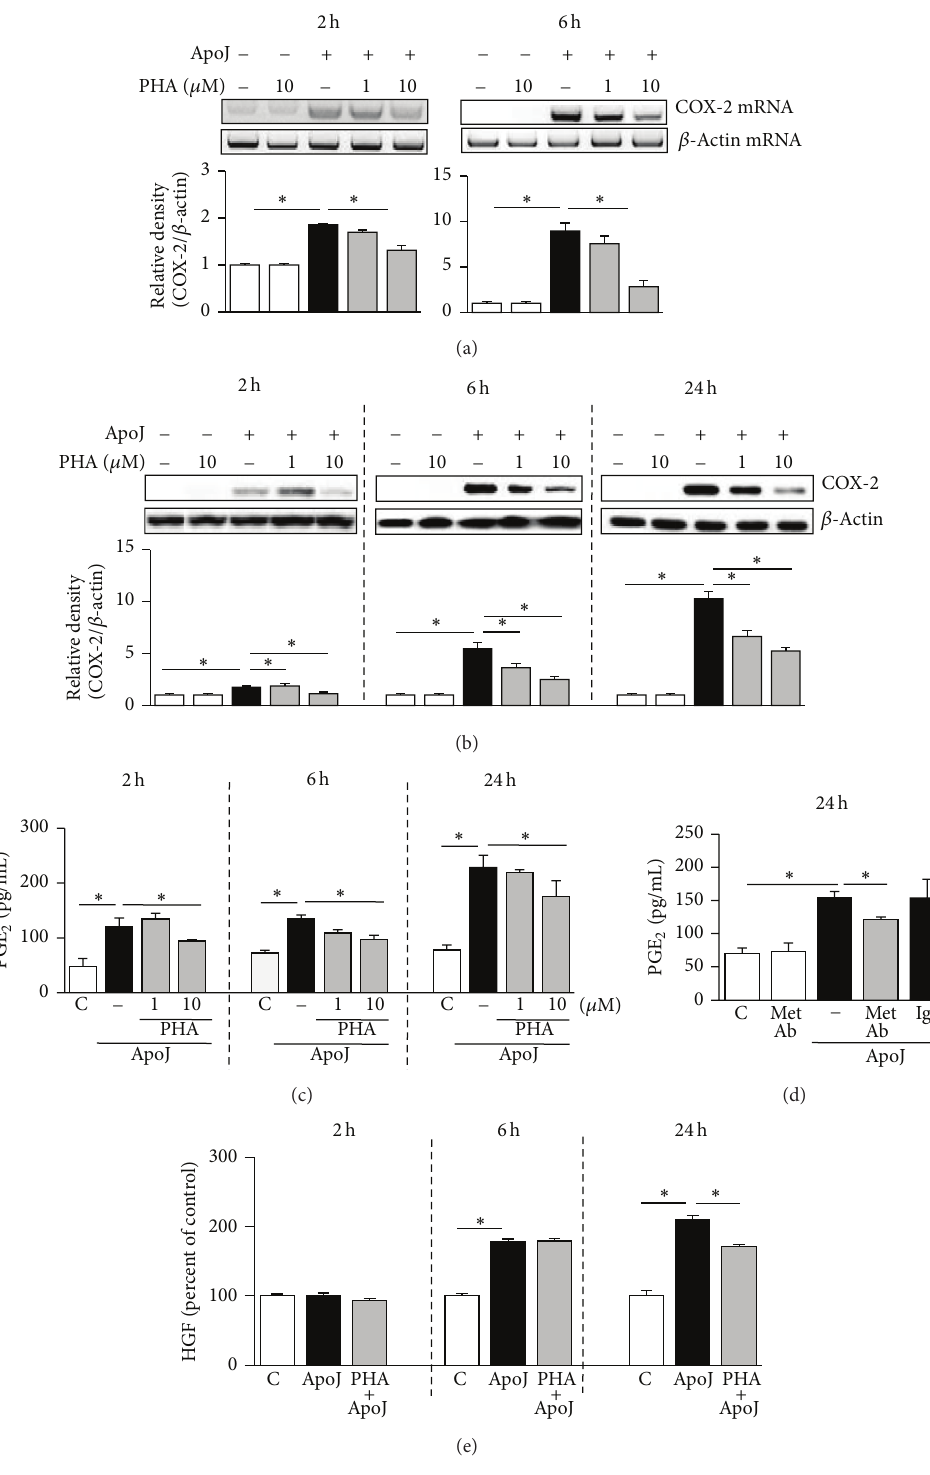
Figure 6: HGF receptor antagonist suppresses COX-2 expression and PGE 2 production in RAW 264.7 cells in response to apoptotic cells. RAW264.7cellswerepretreatedwithPHA-665752(1or10 𝜇 M),c-Metantibody(10 𝜇 g/mL),orIgG(10 𝜇 g/mL)for1handthenstimulatedwith apoptotic Jurkat cells (ApoJ) for the times indicated. (a) COX-2 mRNA levels were analyzed by semiquantitative RT-PCR. Total cell lysates were immunoblotted for COX-2 (b) and cell supernatants were measured for PGE 2 (c, d) by EIA or HGF by ELISA (e). Values represent mean ± SEM of three or more separate experiments; ∗ 𝑃 < 0.05